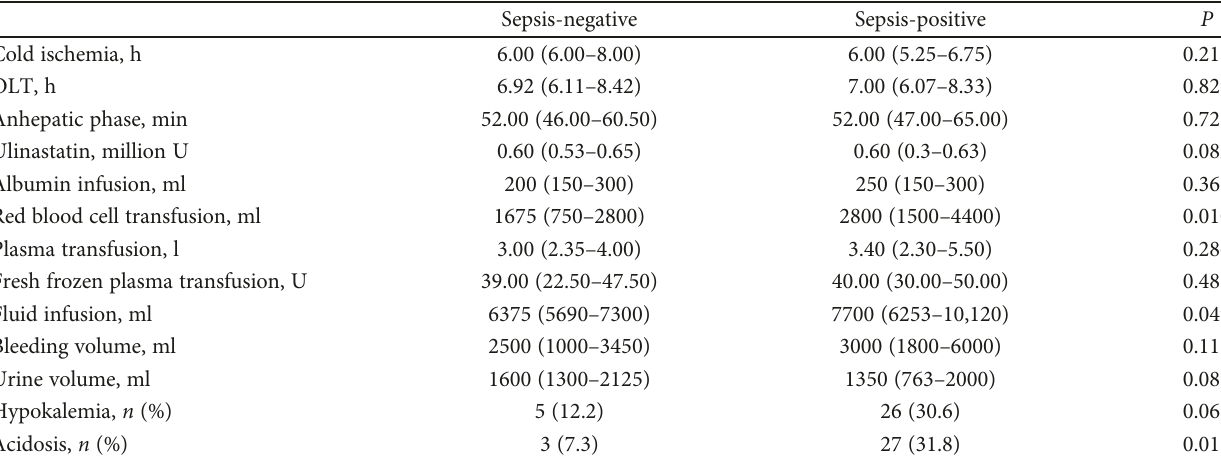
Table 5: Perioperative characteristics of patients with or without orthotopic liver transplantation- (OLT-) related sepsis.